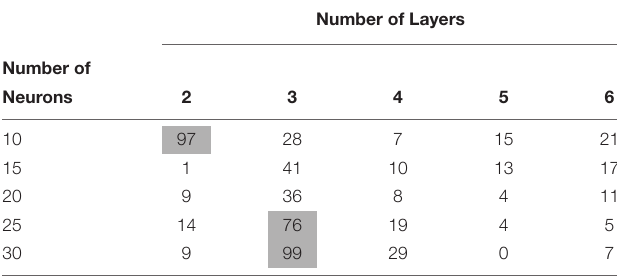
Note: highlighted in gray are the combinations tested with a number of optimal grids larger than